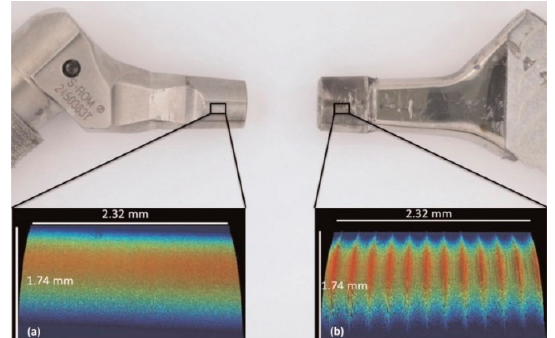
Figure 8. A comparison between the surface topography of the two trunnions considered for visual study in Hothi et al. [41]: (a) smooth, and (b) rough corail tapers. In addition to Hothi et al.’s study [41], the variations of the surface topography were also raised in [26]. In a retrieval study, Stockhausen et al. [26] reported considerable vari- ations in the surface topographies of different designs for the taper junctions. This re- search study was conducted on 46 Ti trunnions with a 12/14 design. They studied the influence of stem topography mated with ceramic/metal heads on the severity of fretting corrosion damage. It was observed that stems mated with ceramic heads were less dam- aged (in the form of both fretting and corrosion) if they were coupled with a smoother trunnion, while, in the case of having a metallic head, there was no meaningful influence of the surface roughness on the intensity of the fretting and corrosion damage scores (Fig- ure 9a). The scoring method was based on the approach proposed by Goldberg et al. [42] through which the damage intensity was classified into four main categories: no damage, mild, moderate, and severe, as illustrated in Figure 9b. The fretting and corrosion damage scores were determined using Cohen’s kappa tests.